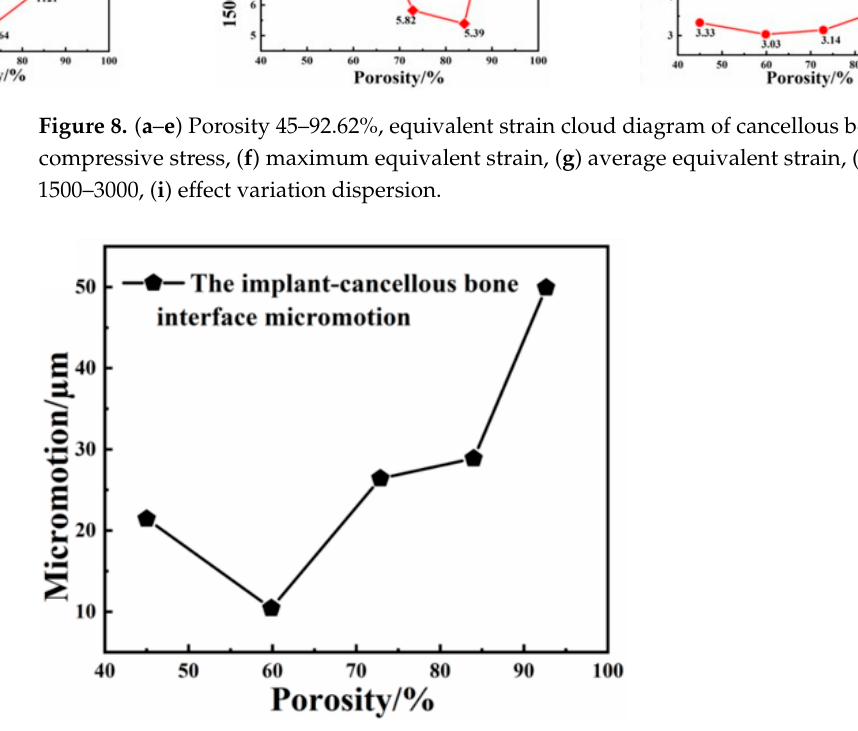
Figure 9. The micro-motion values of the implant-cancellous bone interfaces of each structure.